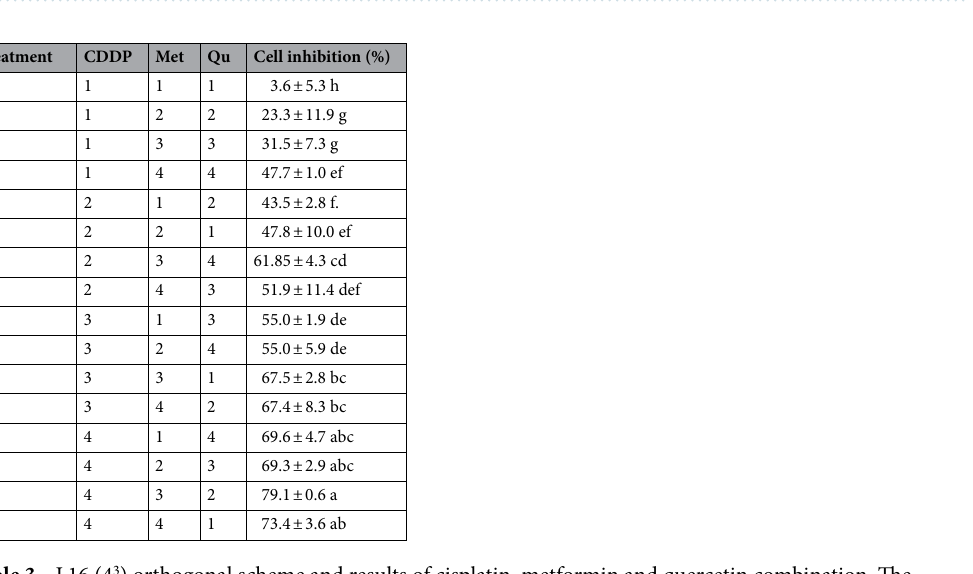
Figure 3. Effect of different combined application order of cisplatin, metformin, and quercetin on the proliferation of Sune-1 cells.